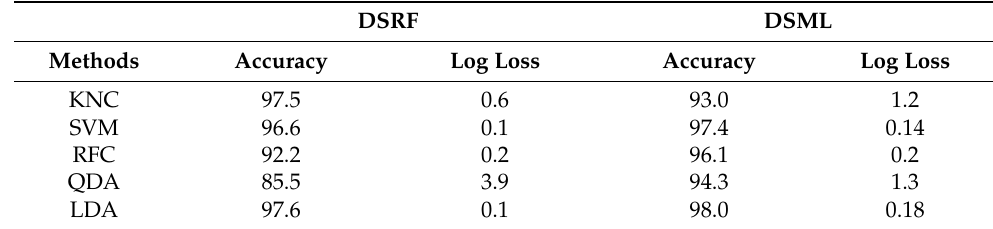
Table 5. Test comparison for different machine learning methods for different training strategies.